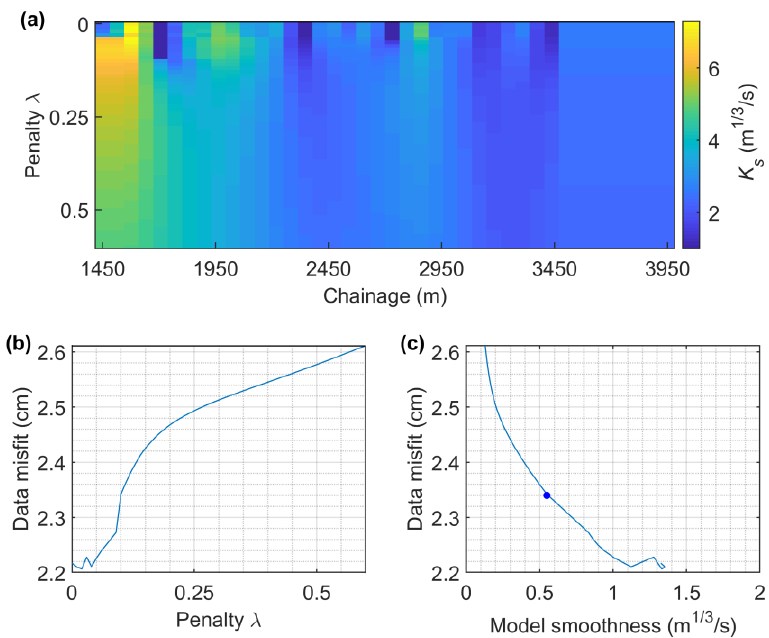
Figure 4. Exemplary sensitivity of parameter K s smoothness ( a ) and model performance ( b ) of the regularization parameter (i.e., penalty λ ). The ℓ -curve ( c ) is shown for the trade-off between data misfit and model smoothness. Note that, the blue dot indicates the ‘best’ λ ℓ used for further calibration.